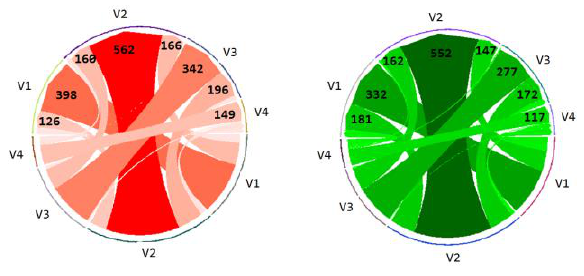
Figure 9. Chord diagrams representing the number of visual transitions from one lead to another (or within the same lead) for the incorrect (left) and correct (right) groups. The thicker the line the more transitions